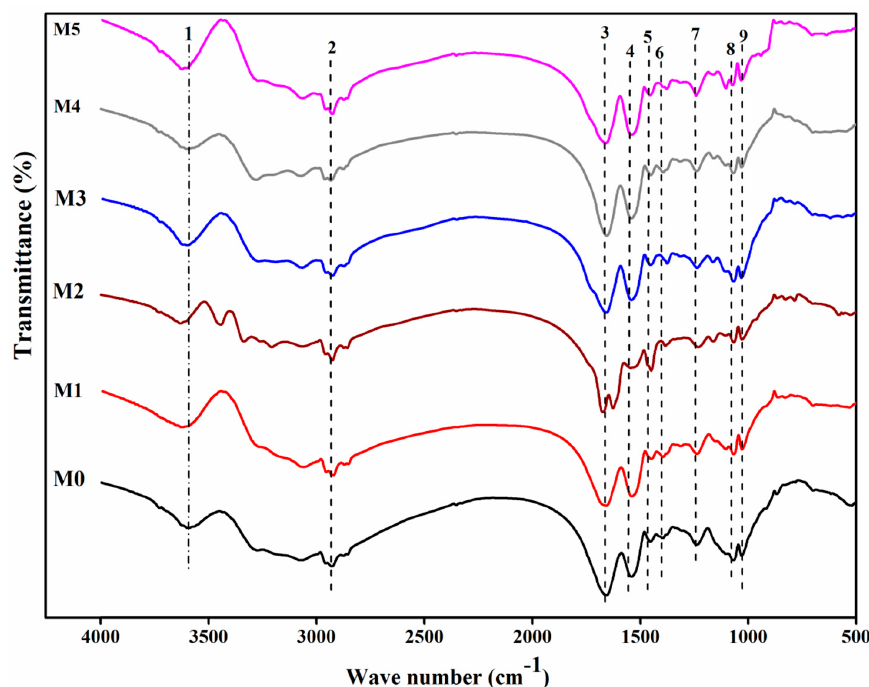
Figure 2. FTIR spectra of the raw and chemically modified D. radiodurans. M0, unmodified biomass. M1, extraction of lipid fraction. M2, modification of amino group. M3, modification of carboxyl group. M4, modification of phosphate group. M5, modification of hydroxyl